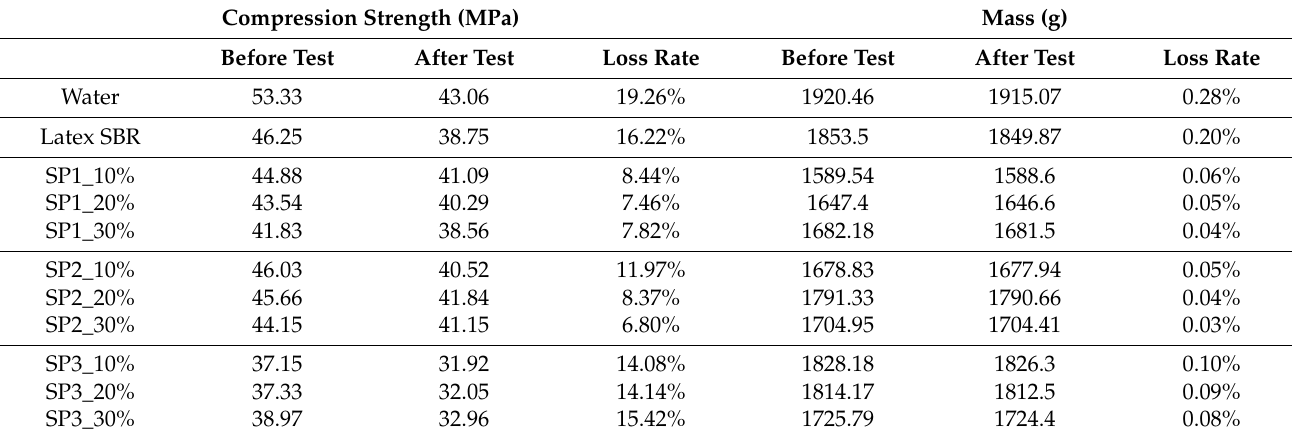
Table 6. Freeze–thaw test data for various groups of the copolymer-modified cement paste samples.